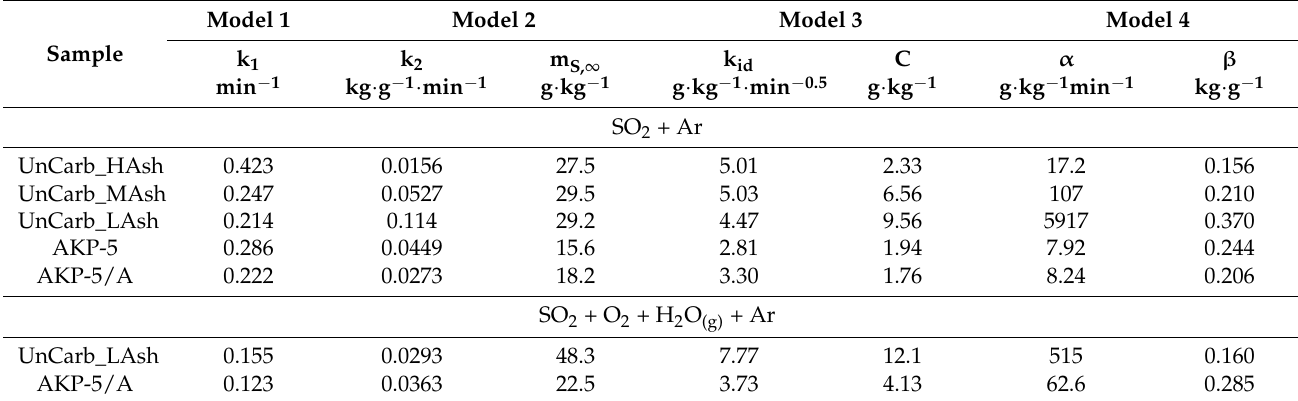
Table 2. Kinetic parameters determined by the method of linear regression.